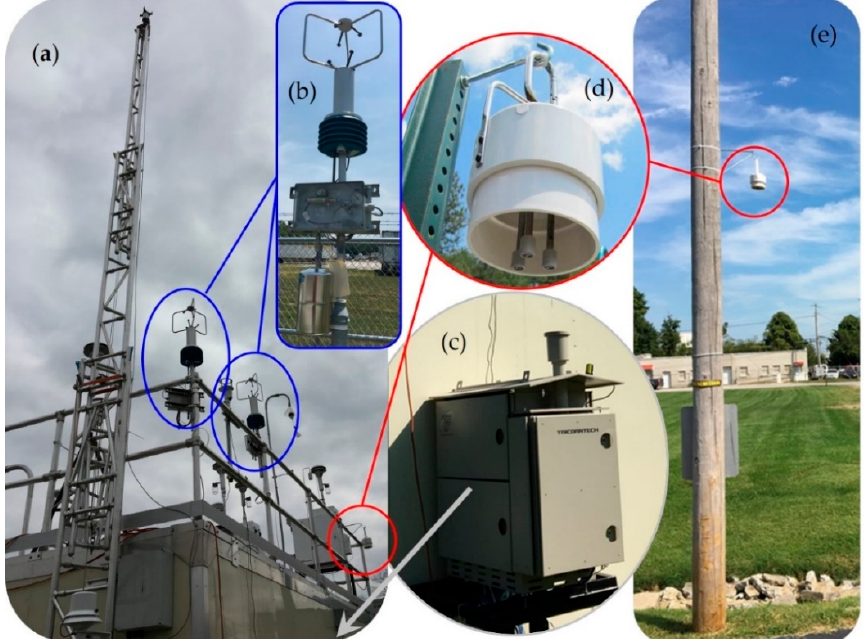
Figure 2. NGEM systems located at (a) S1, LMAPCD monitoring shelter housing auto-GC and other instruments, (b) one of two EPA SPod FSs with ACGS, (c) MiTAP field GC (off frame low), (d) PS at S1 (left circle) and close-up of the PS deployment system (center circle) and, (e) PS at S10 illustrating an elevated deployment in a public area (right circle).